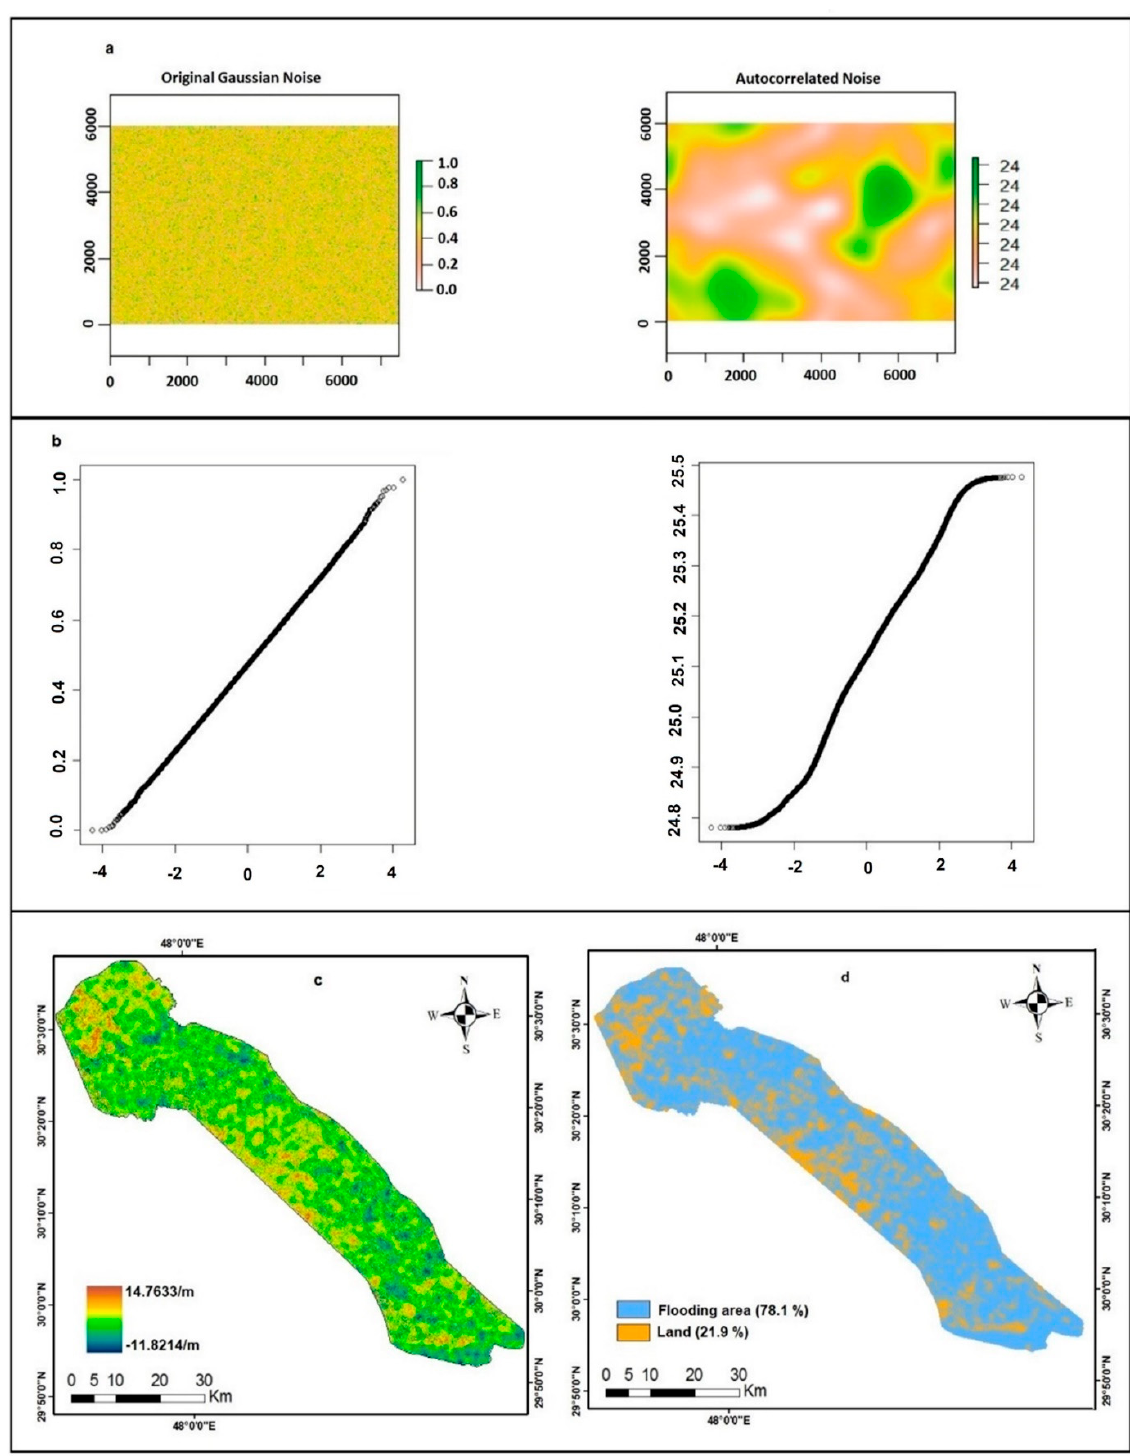
Figure 5. SRTM realizations: ( a ) random Gaussian noise for the SARR and spatially autocorrelated noise following convolution filtering; ( b ) QQ plots of random and convolution-filtered Gaussian noise; ( c ) DEM realization number 10; ( d ) bathtub modelling SRTM realization number 10.